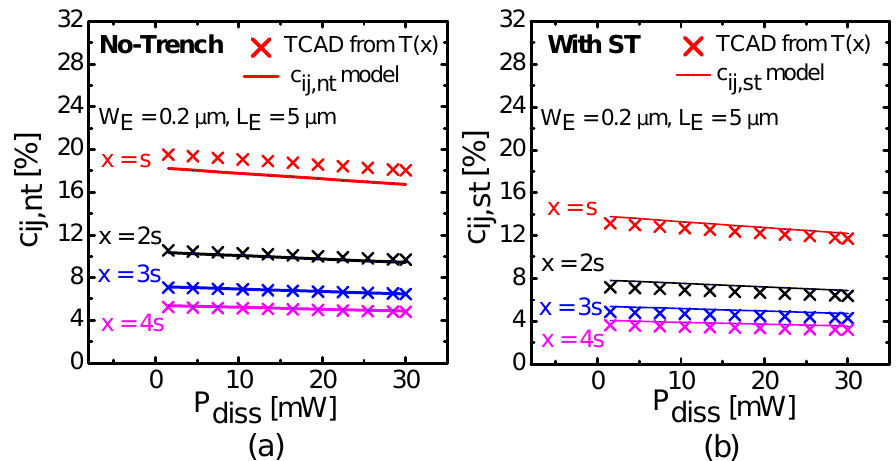
Figure 5. Values of c ij , dt at the sensing fingers for variation in L E at a fixed W E = 0.4 µ m and P diss = 30 mW: A comparison between TCAD results (symbols) and the proposed model (lines) in (9) and (10) of [11].